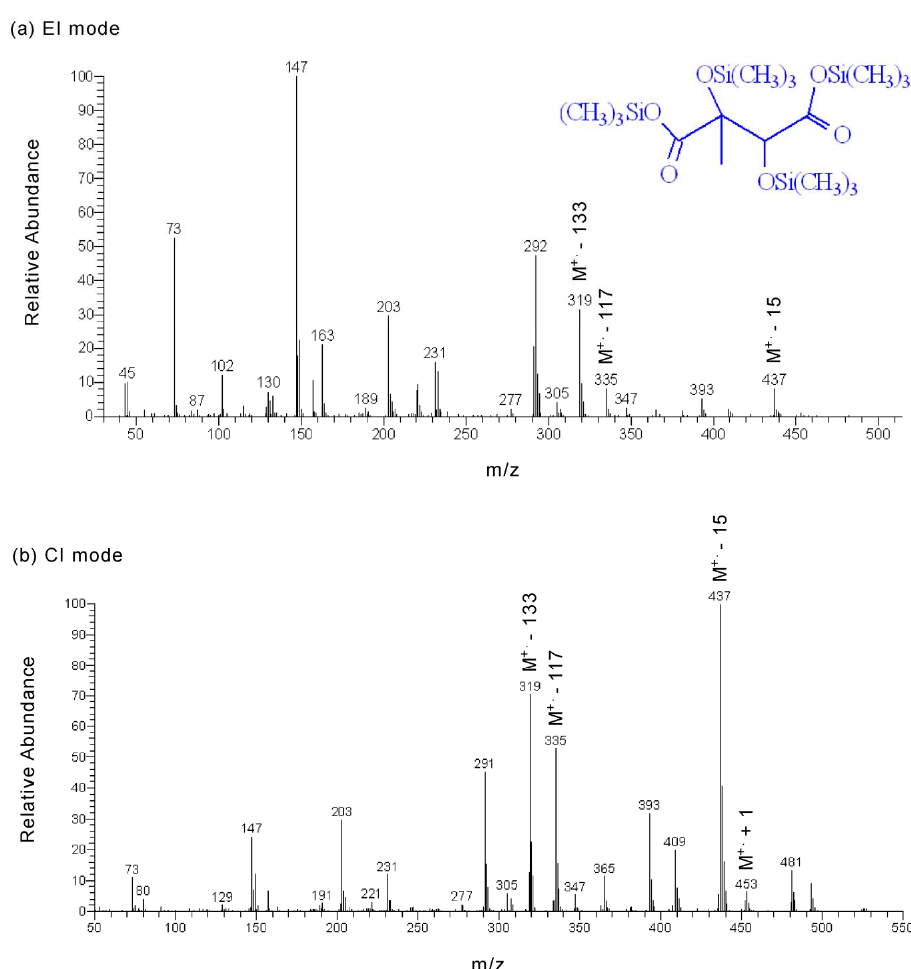
Fig. 5. Mass spectra of (42 and 46 from Fig. 3) tentatively identified as 2,3-dihydroxy-2-methylsuccinic acid.